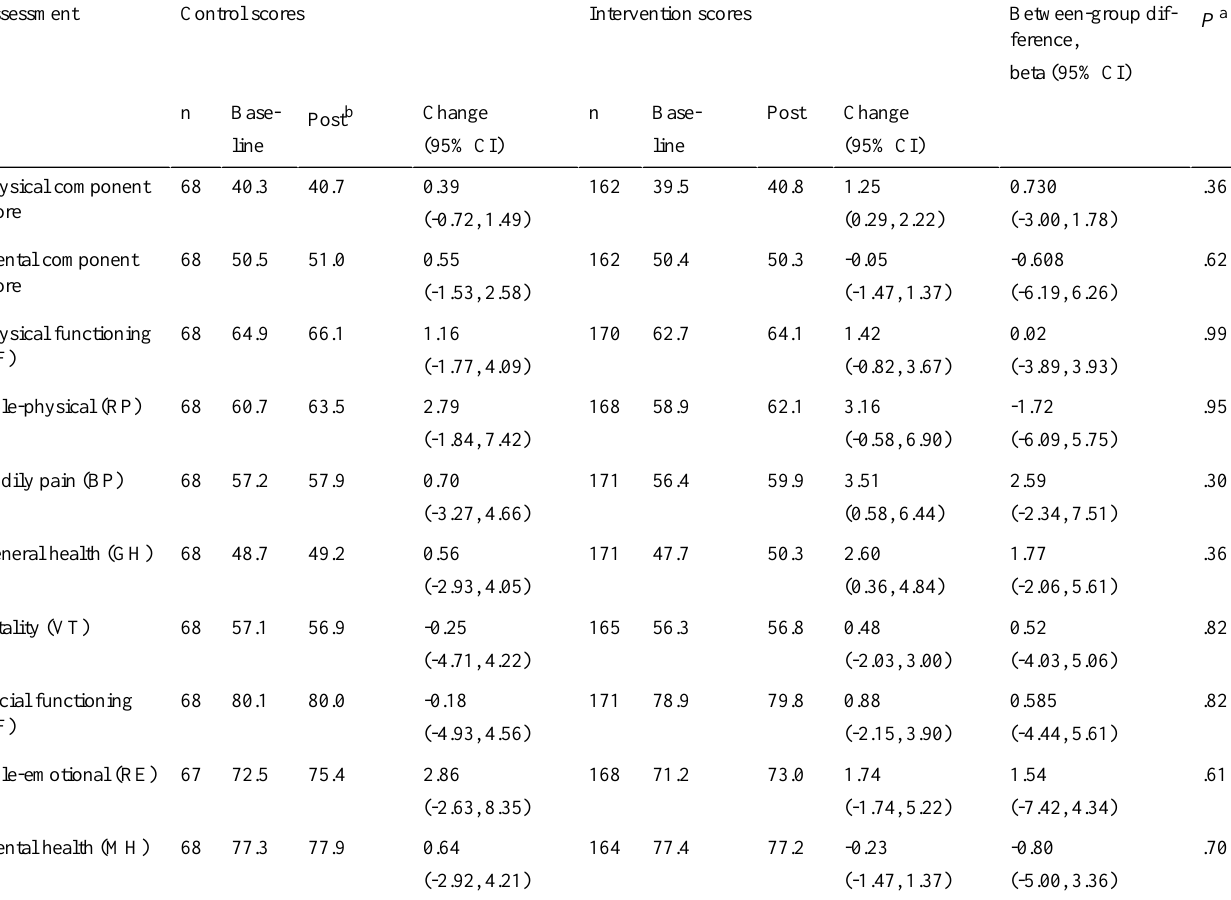
a P values show the level of statistical significance between the treatment arms. b Postintervention